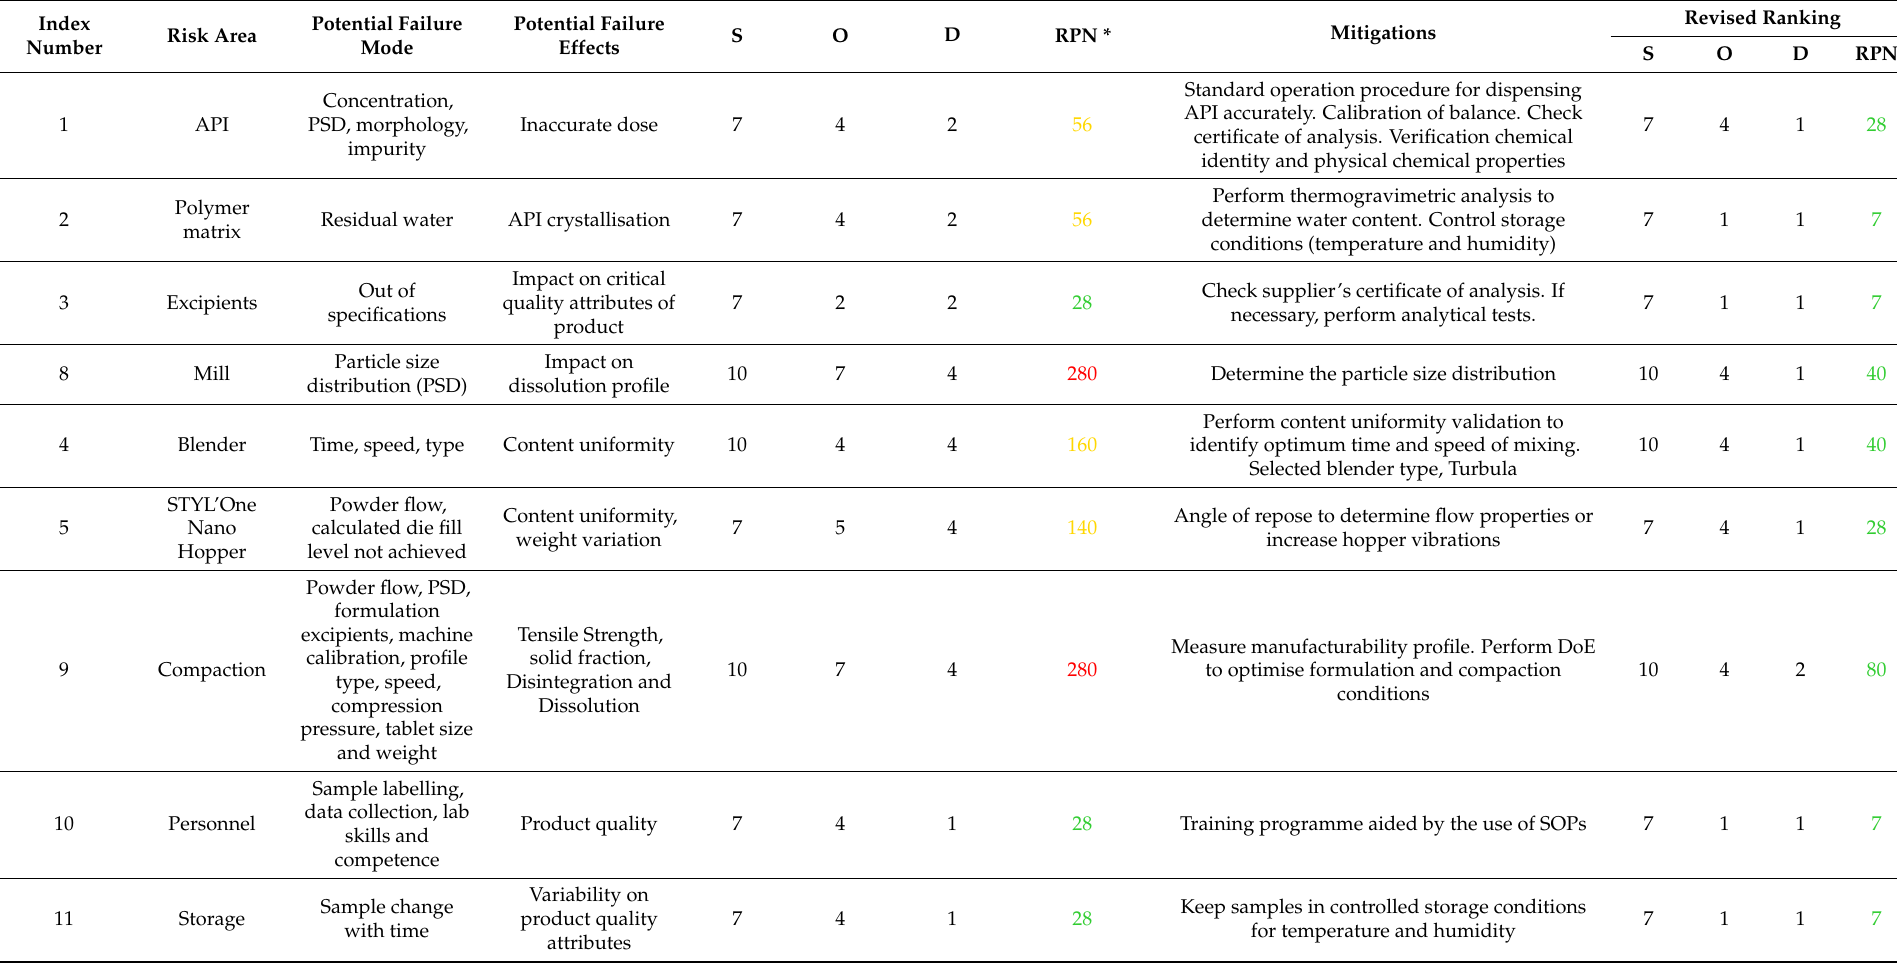
Table 2. Risk assessment using Failure Mode Effect Analysis (FMEA) for ITZ ASD manufacture and ASD tablet